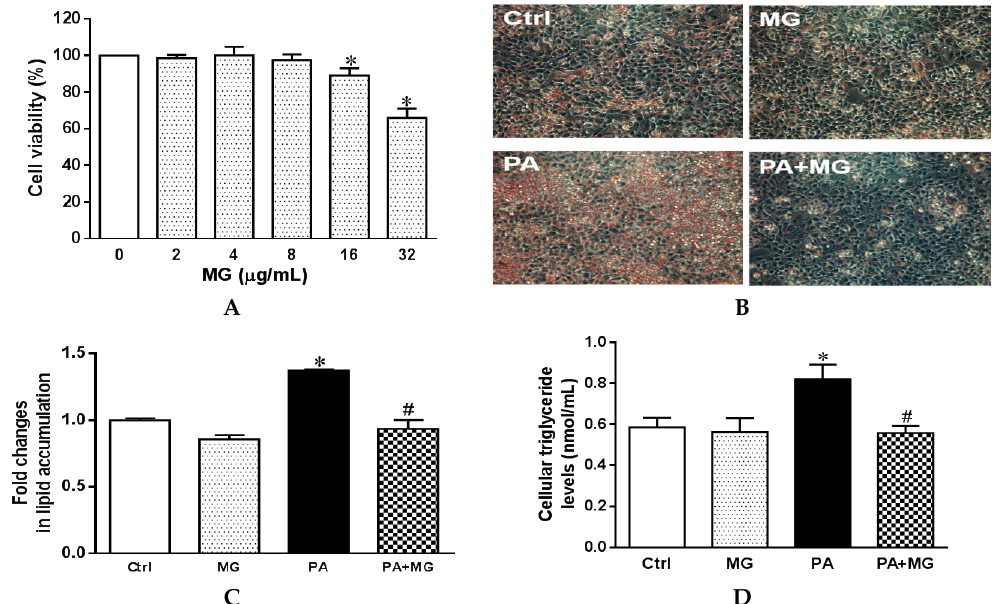
Figure 4. E ff ects of magnolol (MG) treatment on cell viability and lipid accumulation in steatotic HepG2 cells. ( A ) Cell viability of HepG2 cells treated with MG (0–32 µ M) for 24 h expressed as optical density percentage; ( B ) photomicrograph of Oil Red O staining (20 × ); ( C ) colorimetric assay for quantification; ( D ) triglyceride levels of the supernatant fraction in HepG2 cells. Data are expressed as mean ± SEM, n = 4. * p < 0.05 vs. Ctrl; # p < 0.05 vs. palmitic acid